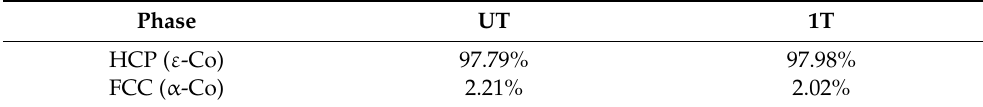
Figure 3. Distribution of two phases in bulk Co sample and pole figure of the FCC and HCP phases. Red: FCC; blue: HCP. ( a , c , e ) UT; ( b , d , f ) 1T. Table 1. Content of phase of bulk Co sample before and after the PMT.